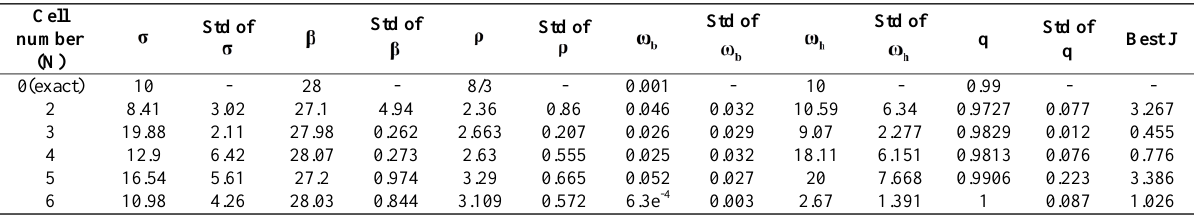
Table 1. Results obtained by GA method for parameter estimation of approximated fractional-order Lorenz system with 2, 3, 4, 5, and 6 cells.